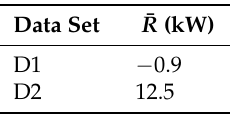
Table 3. Statistical behavior of the residuals between measurement and estimation, for the D0 and D1 data sets.